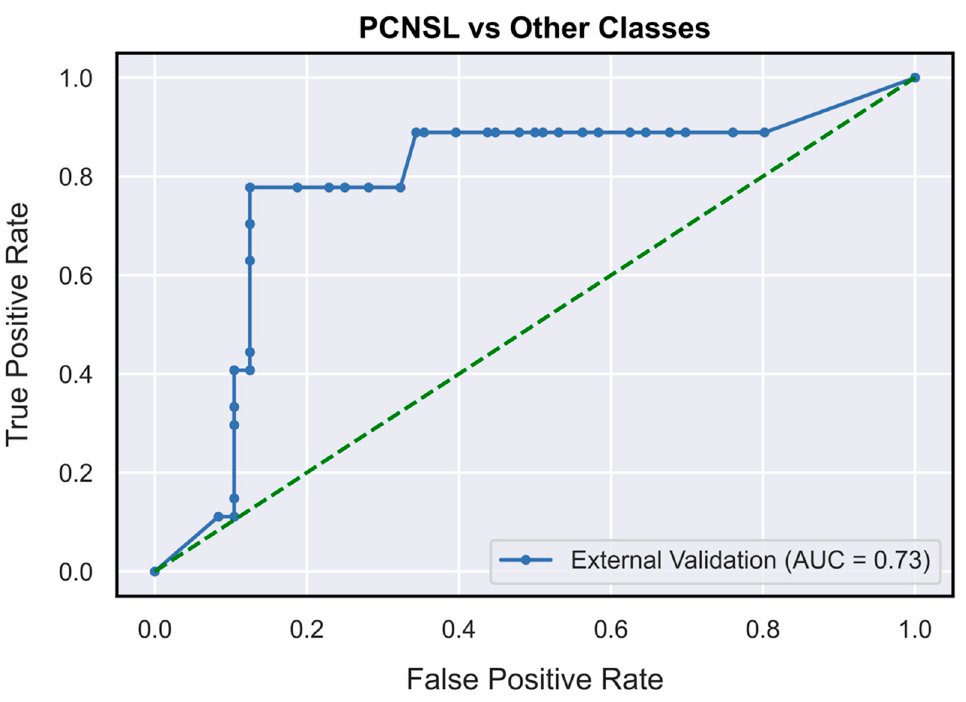
Figure 2. AUC-ROC curves (on TeS validation dataset) for PCNSL diagnostic outcome class (OVR). OVR: one-vs-rest; PCNSL: primary central nervous system lymphoma.